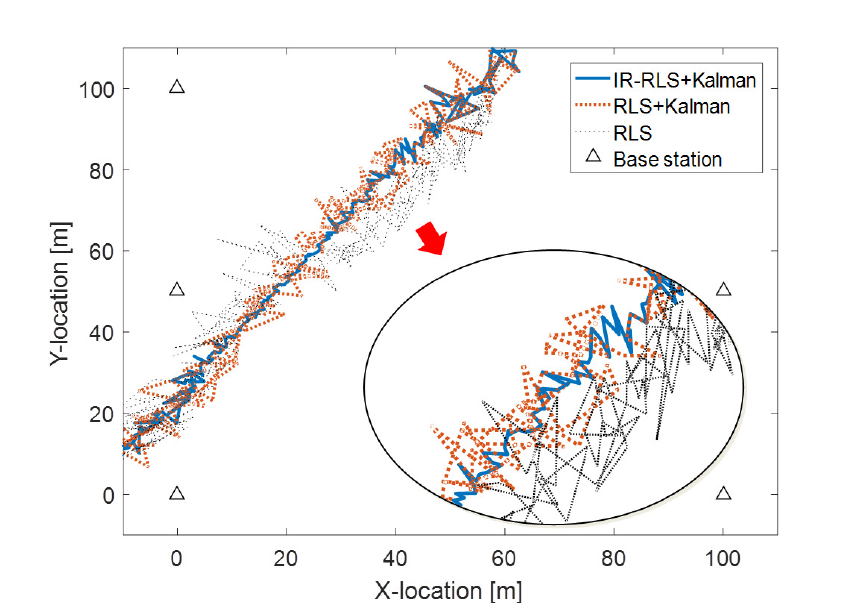
Figure 2. Estimated trajectory comparison between iteratively reweighted- recursive least squares (IR-RLS) and RLS